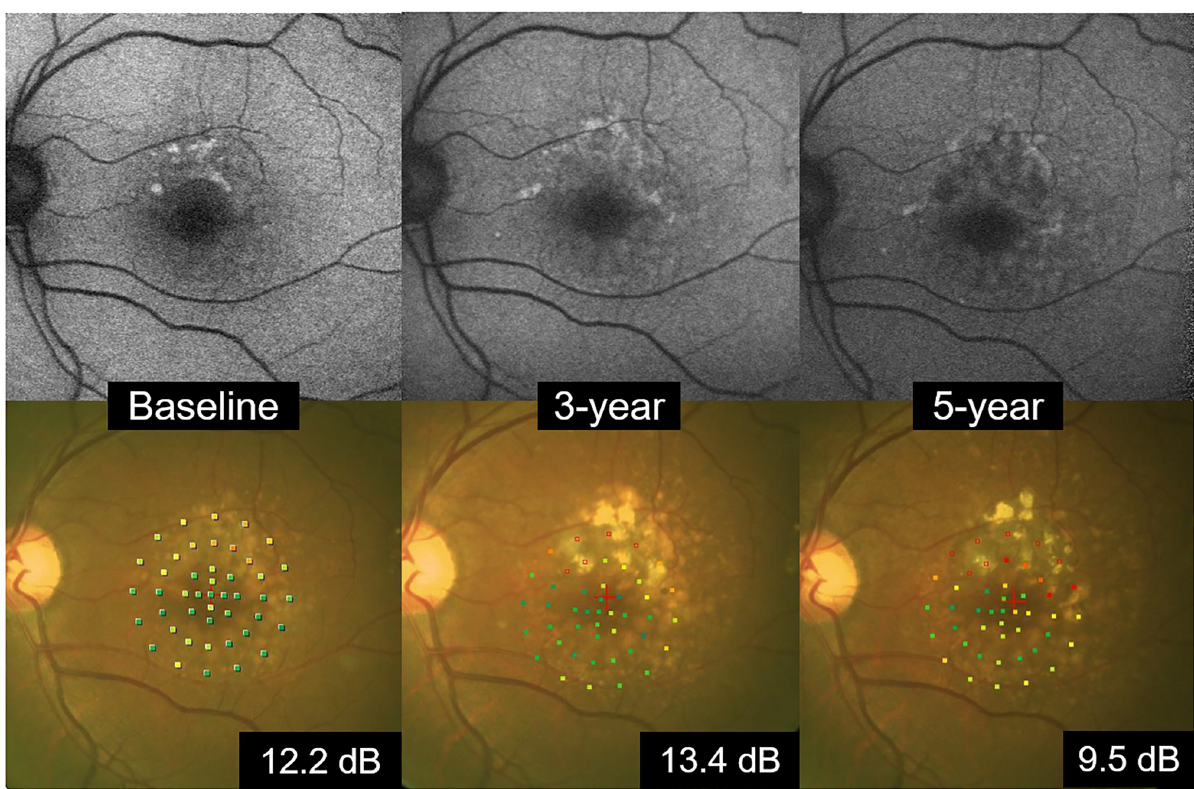
Fig 4. A representative case of FAF imaging and color fundus imaging. A 66-year-old man. The focal increase FAF pattern was seen at baseline, and the mean retinal sensitivity was 12.2 dB. In 3 years, the portion showing hyperfluorescence at baseline changed to hypofluorescence in part, and the hyperfluorescence expanded and changed to the patchy pattern. In the fundus photograph, drusen increased during the 5 years. The mean retinal sensitivity was 13.4 dB at the 3 rd year and 9.5 dB at the 5th year.